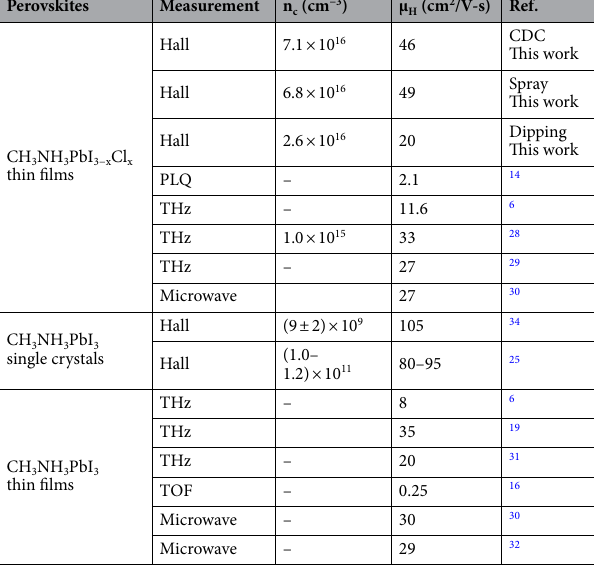
Table 1. The RT Hall carrier concentration (n c ) and mobility (μ H ) of CDC, spray and dipping deposited CH 3 NH 3 PbI 3−x Cl x thin